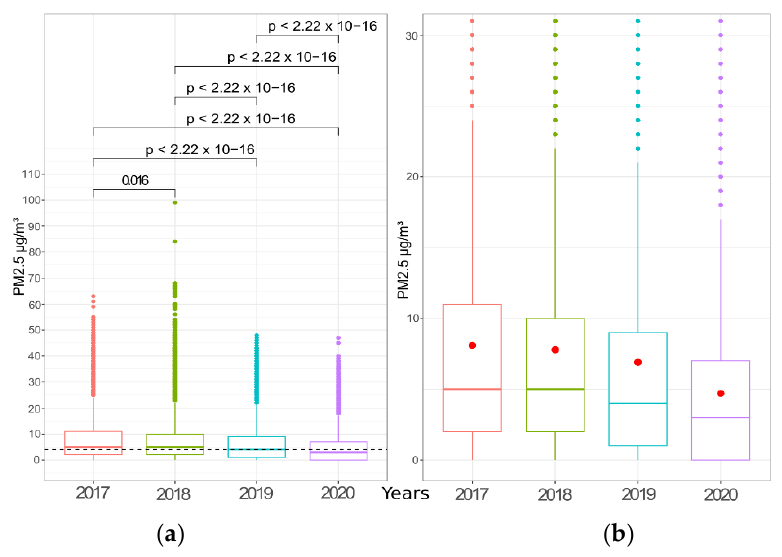
Figure 5. Comparison among the four years for the period January to September for the Habay air quality station (rural station). The p –values are the results of a Mann–Whitney Wilcoxon pairwise test with the Holm correction ( α threshold = 0.05). The dashed line corresponds to the median (4 µ g/m 3 ) of the four years for the period. ( a ) complete dataset; ( b ) detail from 0 to 30 µ g/m 3 ; averages in red points.